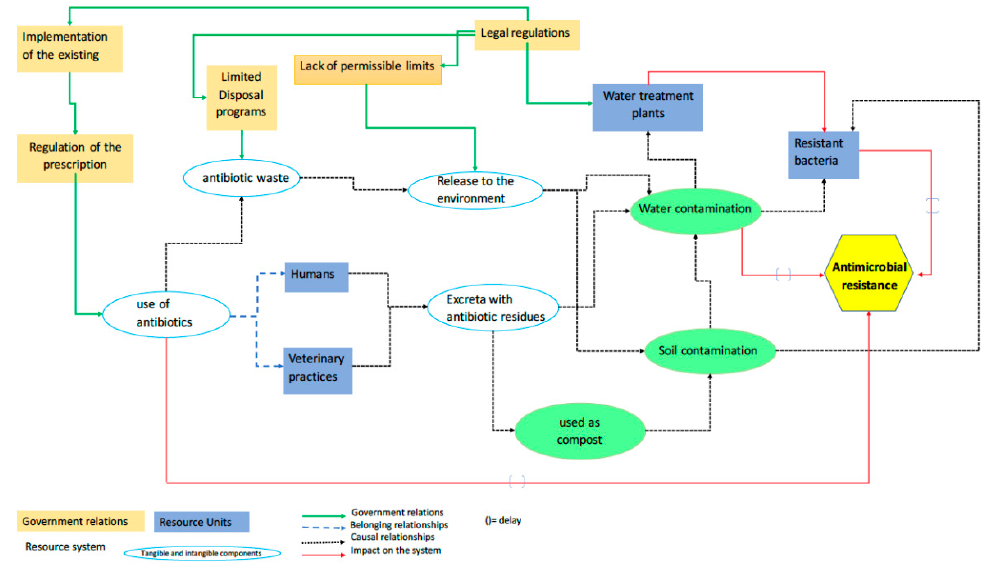
Figure 2. Determinants in the antimicrobial resistance problem.